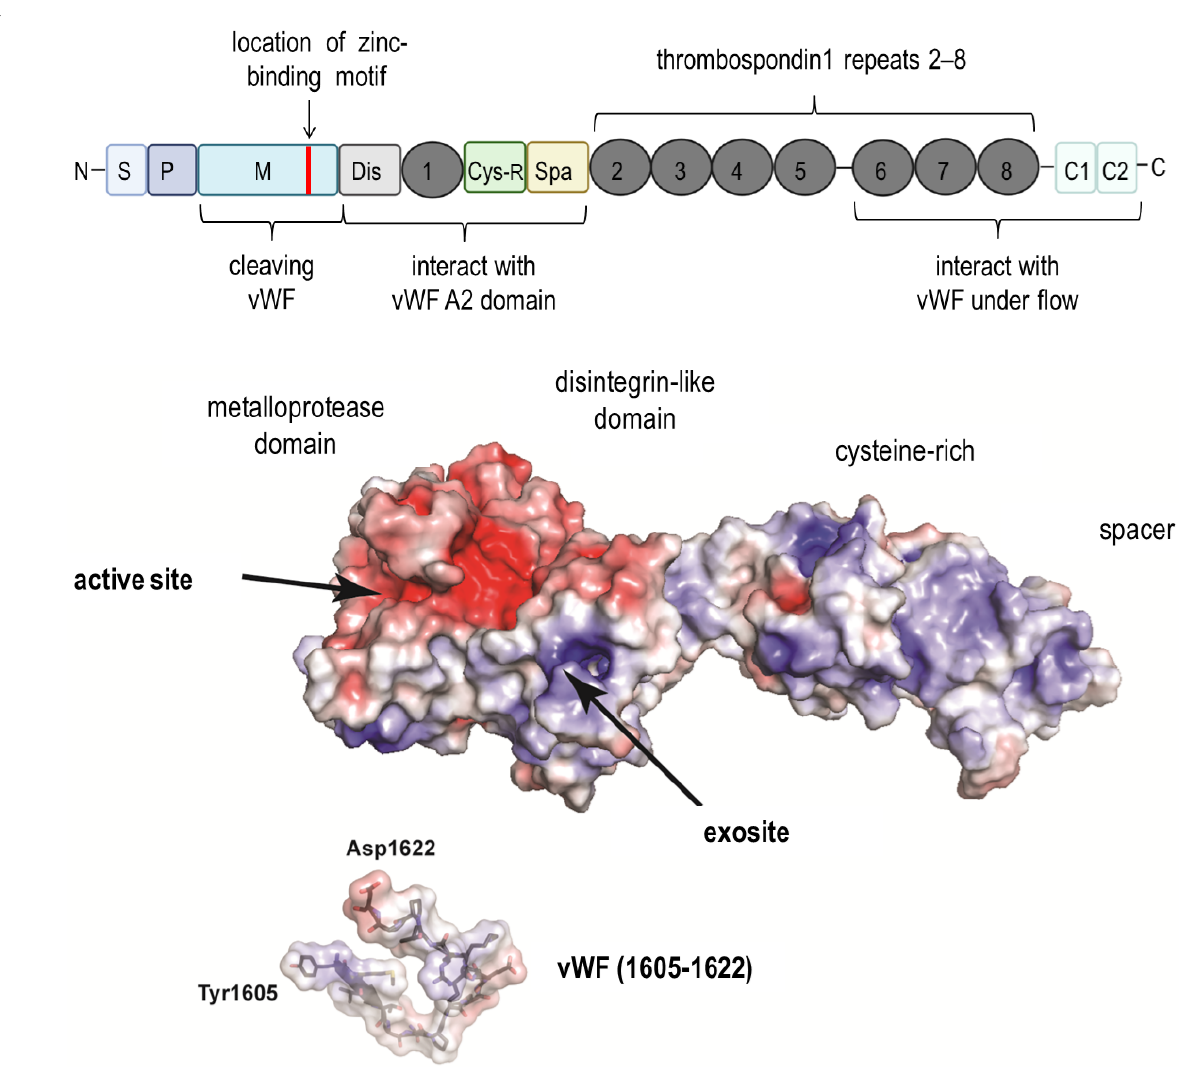
Figure 1. Representation of the ADAMTS13 structure. ( A ): The structural domains indicated are: signal peptide (S), propeptide (P), metalloprotease (M) (location of zinc-binding motif shown in red), disintegrin domain (Dis), first thrombospondin type 1 (TSP1) repeat (1), cysteine-rich domain (Cys-R), spacer domain (Spa), the second to eighth TSP1 repeats (2) through (8) and two CUB domains (C1 and C2). The metalloprotease domain is the catalytic center that cleaves VWF. The proximal carboxyl-terminal domains from Dis to Spa interact with the A2 domain of VWF. More distal carboxyl-terminal domains (TSP1 2–8) interact with VWF under fluid shear stress. ( B ): Structure of ADAMTS13 metalloprotease to spacer domains with a VWF peptide encompassing the scissile bond. The electrostatic surface is shown with positive charges in blue and negative charges in red.